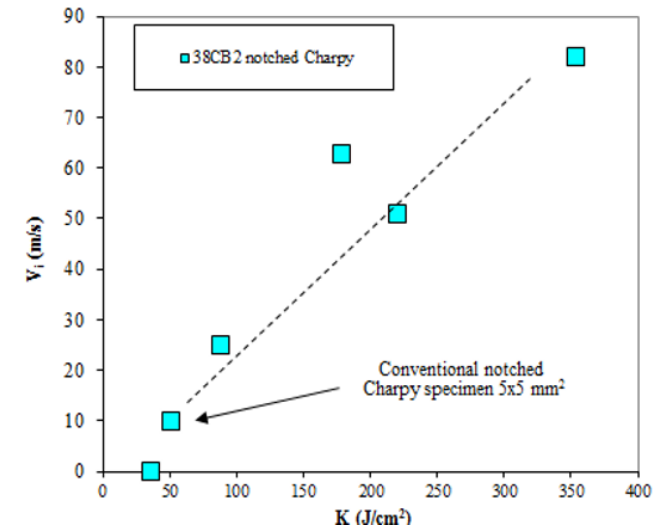
Fig. 6. Failure energy of the three-point bend specimens as a function of impact